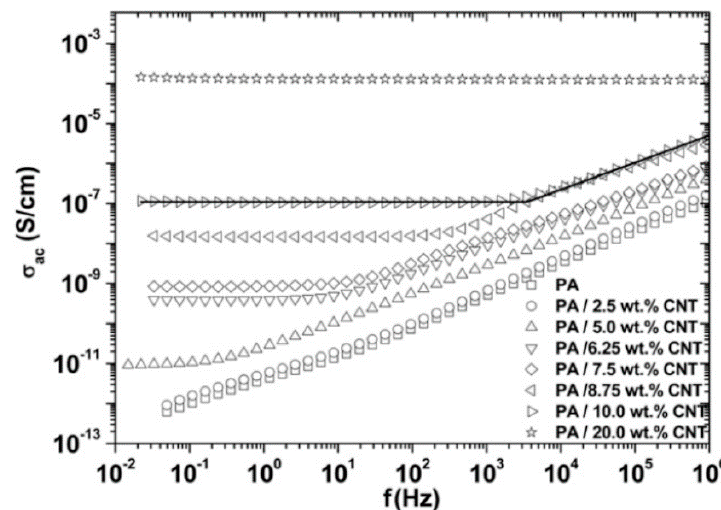
Figure 8. Variation of conductivity with frequency for MWCNT / PA composite with varying amounts of MWCNT at room temperature [4].